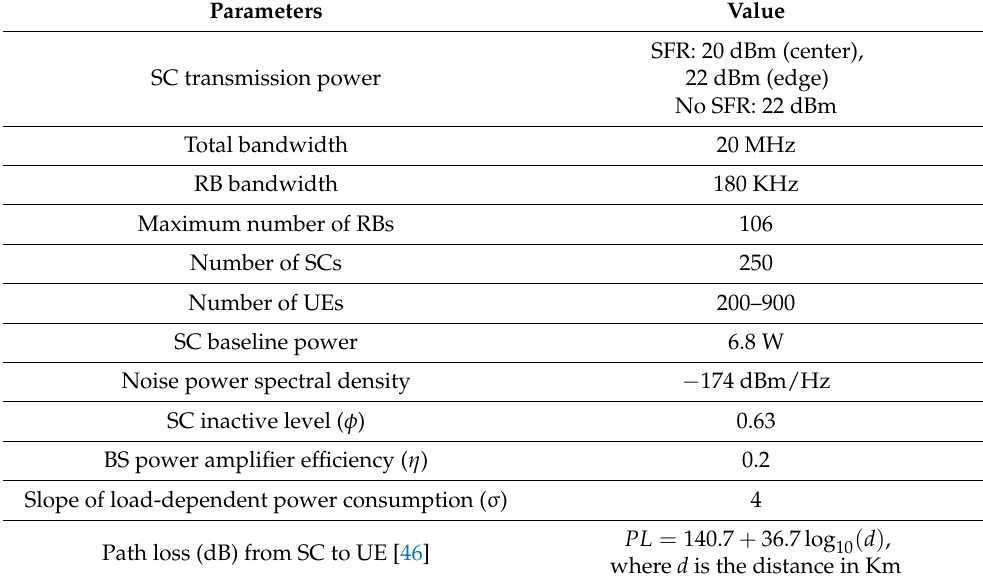
Table 2. Simulation Parameters.